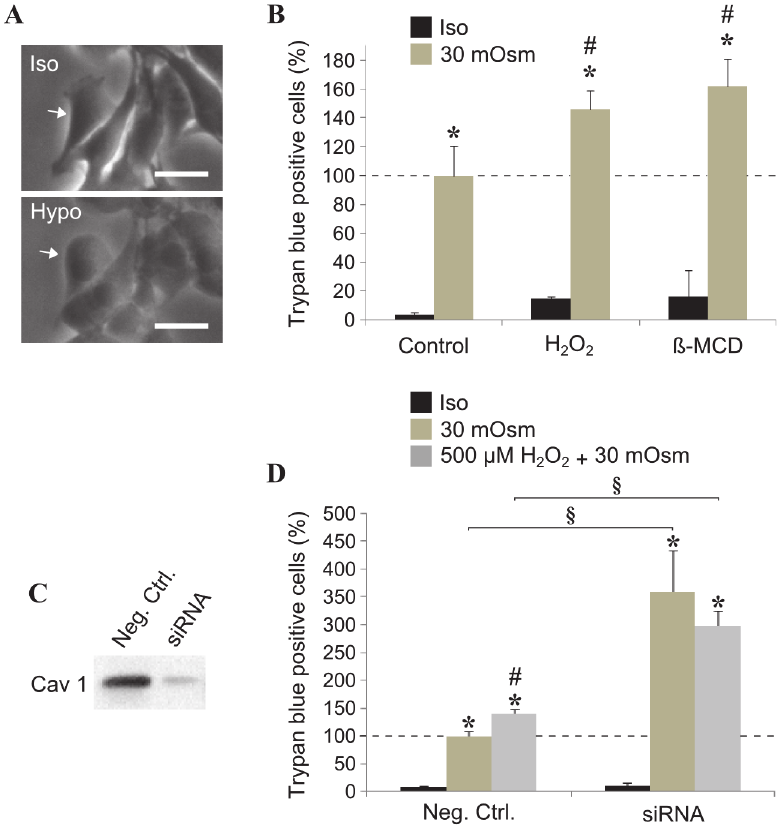
Fig 6. Effect of H 2 O 2 on cell membrane rupture in hypo-osmotic conditions. Myoblasts were grown in iso- (300 mOsm) or hypo-osmotic medium (30 mOsm). Cell swelling was observed by light microscopy after 5 min (A). Cells were pre-incubated (or not) with H 2 O 2 or β -methyl-cyclodextrin ( β -MCD), left in iso- or hypo- osmotic medium for 30 min and stained with Trypan Blue (B). The cells were treated with a caveolin 1 siRNA or a negative control as described in material and methods. The reduction of caveolin 1 expression was confirmed by western blot (C) and the above swelling protocol was applied to the cells pre-incubated (or not) with 500 μ M H 2 O 2 (D). A minimum of 100 cells were counted by experiment and the Trypan blue positive cells were expressed as a percentage of the cells submitted to hypo-osmotic stress ( — in B and D). Bars on the graph represent the SEM. * Significantly different from the relative iso-osmotic sample ( P < 0.05). # Sig- nificantly different from the untreated related control (without H 2 O 2 , P < 0.05). § Significantly different from the negative control ( P < 0.05). Scale bar = 30 μ